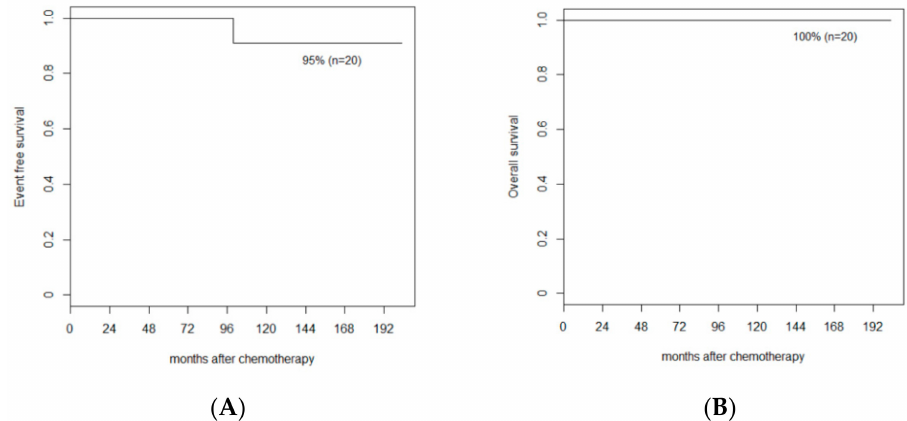
Figure 2. Patient survival. ( A ) Event free survival rate of all the patients. ( B ) Overall survival rate of all the